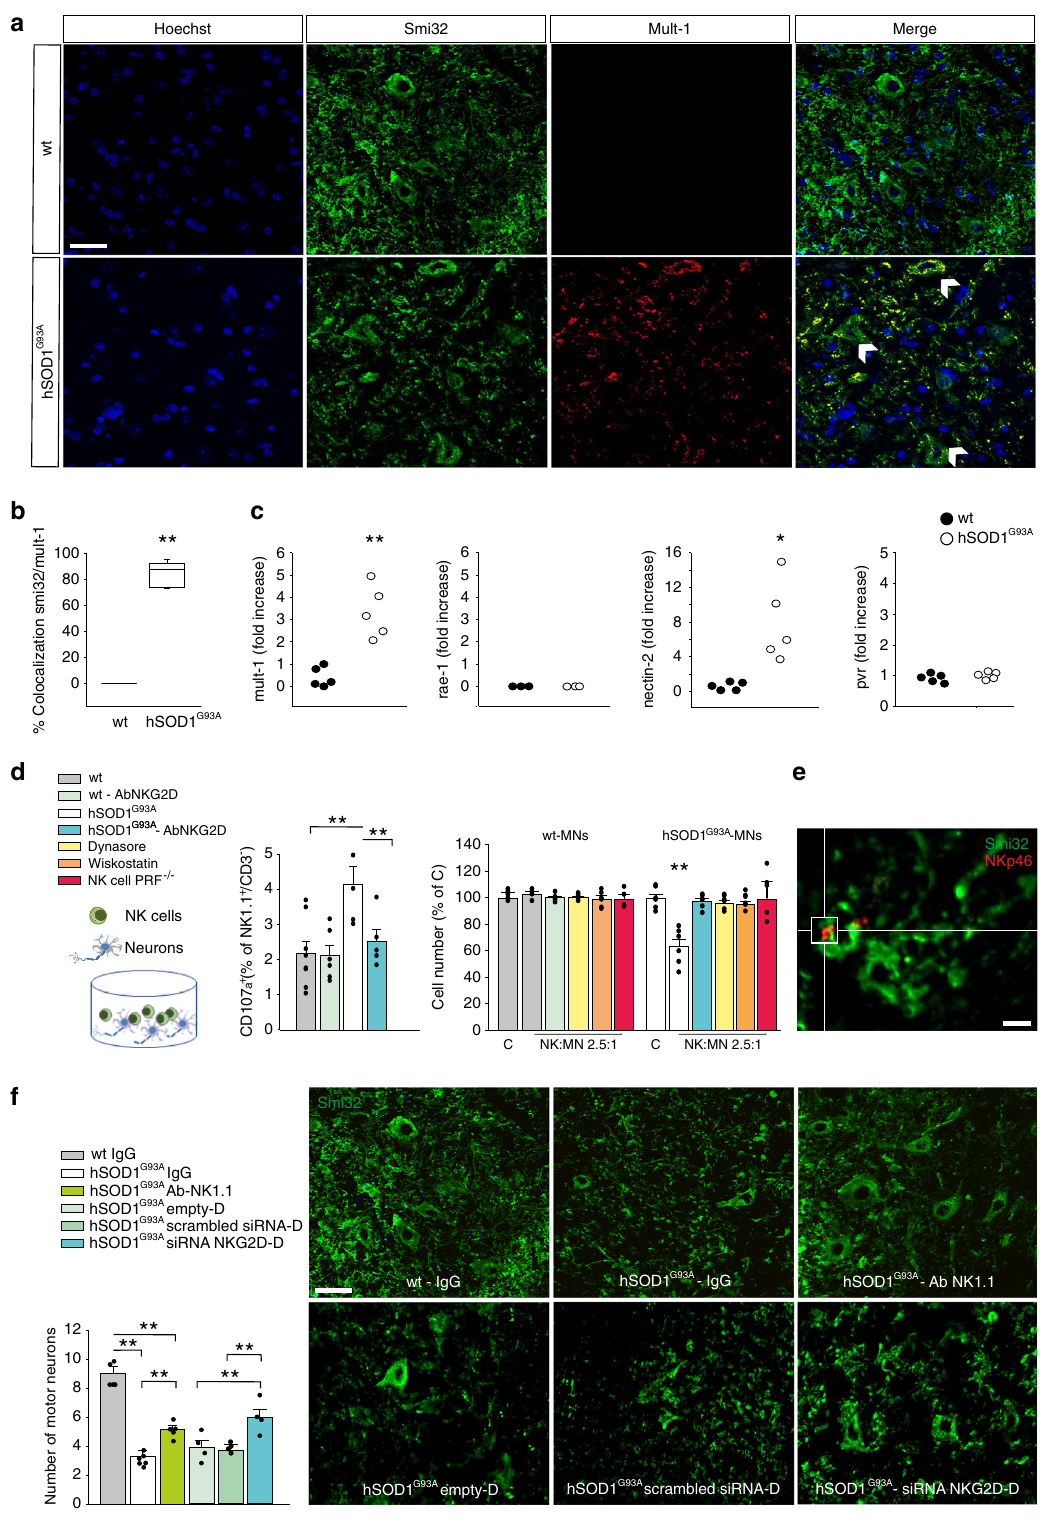
blood of sALS patients and controls, seen as CD107a expression upon interaction with NK-susceptible tumor (K562) target cells (Fig. 7g), and also the expression of GZMb and PRF did not differ (Fig. 7h,